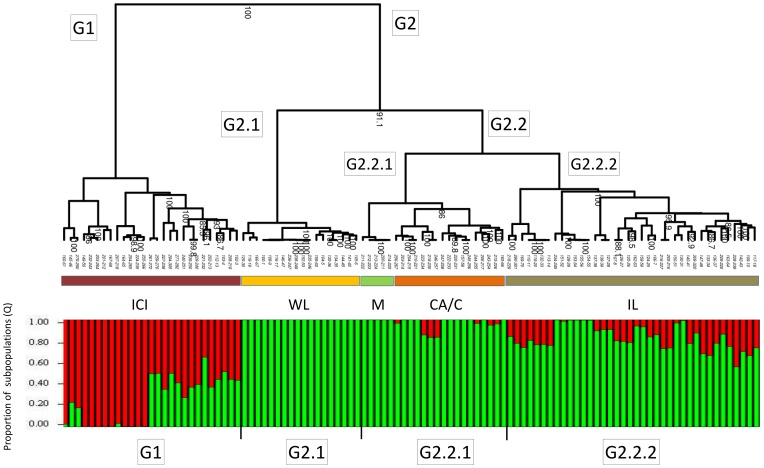
Dendrogram and genetic structure of 105 accessions in the ARO pomegranate germplasm collection.Genotyping of 105 pomegranate accessions from the ARO collection was performed with 346 SNPs. The genotyping results were used to classify the accessions into subpopulations and reveal their genetic structure. Classification was performed by drawing a dendrogram based on 1-PSA as genetic distance. Only confident branches with bootstrap values above 85 were assigned. The two major groups are notated as G1 and G2, and G2 was further divided into G2.1 and G2.2, giving altogether three groups of related accessions. The colored horizontal bars correspond to phenotypically homogeneous pomegranate groups of accessions: India-China-Iran (ICI), “Wonderful-like” (WL), Mollar (M) Central Asia and California (CAC), and Israel (IL). Genetic structure was revealed by STRUCTURE program with K = 2 as found by simulation and δK likelihood method. The two subpopulations (K = 2) are represented as green and red bars. The division of STRUCTURE's Q-value bar plot into four (vertical lines) corresponds to the four major significant clusters in the dendrogram.